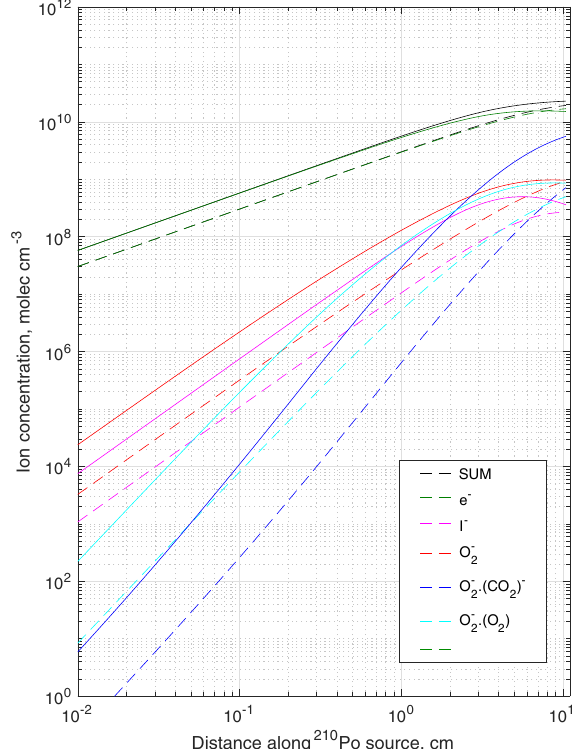
Figure 3. Ion densities – arbitrary units – along the 210 Po source tube for flow conditions of 306hPa ambient pressure (dashed lines) and 1013hPa (solid lines). The predominant ion after e − is ( CO 2 ) and I − is the O − 2